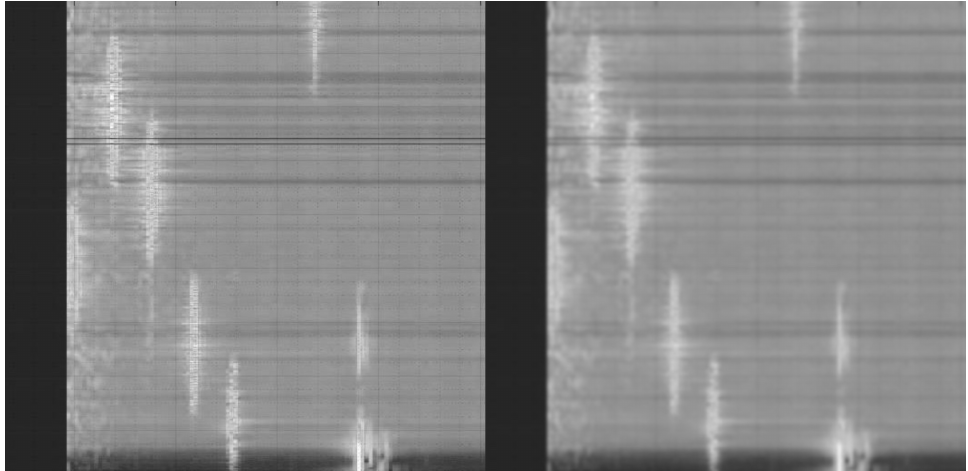
Figure 7. The left image is the one obtained after converting into each channel and the right one is the Gaussian blurred image